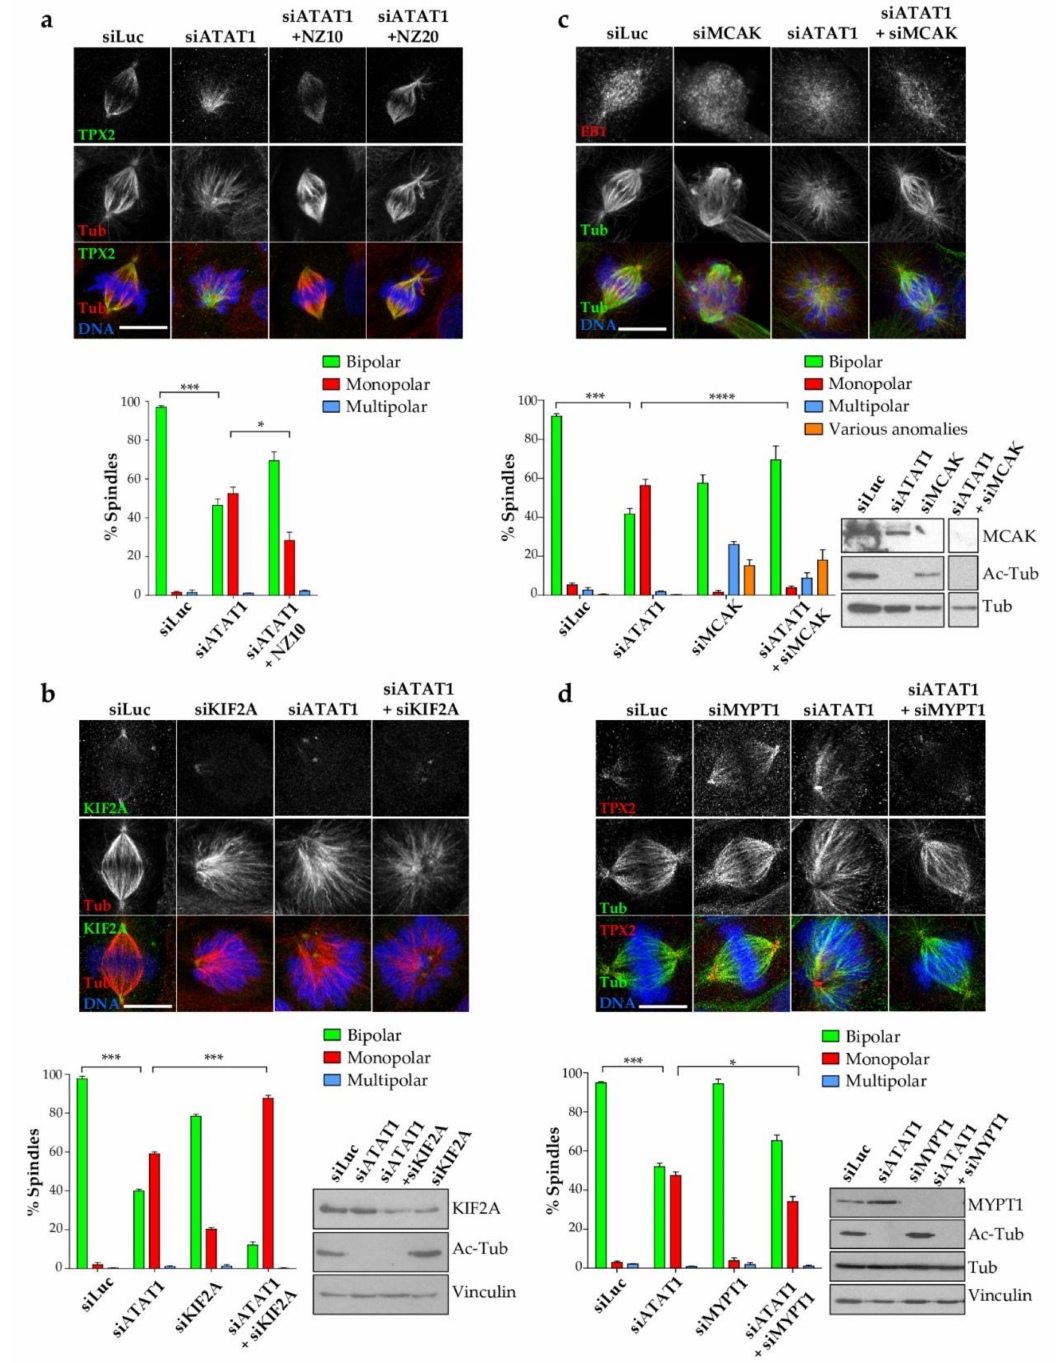
Figure 7. MT-plus-end stabilization and restoring centrosomal PLK1 activity rescue the si ATAT1 -induced monopolar spindle phenotype. ( a ) LLCPK1 cells were transfected for 48 h with siRNAs directed against luciferase and ATAT1 . ATAT1 -depleted cells were further treated with nothing or with low doses of nocodazole (10 or 20 ng/mL) for 5 h before fixation and immunostaining for tubulin, TPX2 , and DNA. Representative MIP images are shown (scale bar 12.5 µ m). Sorting of the spindle phenotypes in three classes (bipolar, monopolar, multipolar) was done by blind manual counting (>200 mitotic cells per condition and per experiment, n = 3). ( b ) LLCPK1 cells were transfected for 48 h with siRNAs directed against luciferase, ATAT1 , KIF2A, or a combination of KIF2A and ATAT1 . Cells were either lysed or fixed. Cell lysates were analyzed by western blot using acetyl-tubulin and KIF2A antibodies to estimate depletion efficiencies and anti-vinculin as loading control. Fixed cells were immunostained for tubulin, KIF2A, and DNA. Representative MIP images are shown (scale bar 8 µ m). Phenotype quantification was performed as in ( a ). ( c ) LLCPK1 cells were transfected for 48 h with siRNAs directed against luciferase, ATAT1 , MCAK, or a combination of MCAK and ATAT1 . Cells were either lysed or fixed. Cell lysates